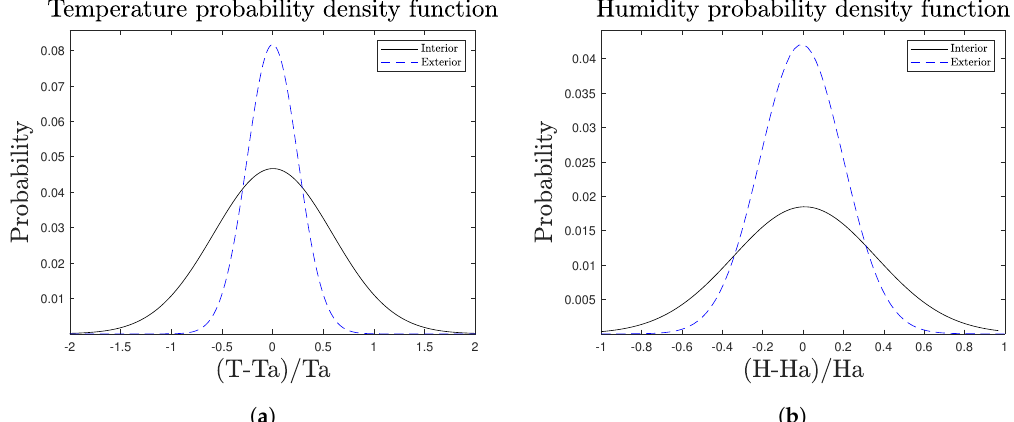
Figure 16. Comparative graphs of temperature and humidity PDFs of the COMFORT (Interior) and METEO (Exterior) nodes, obtained for the month of December. ( a ) Temperature PDF, ( b ) Humidity PDF.